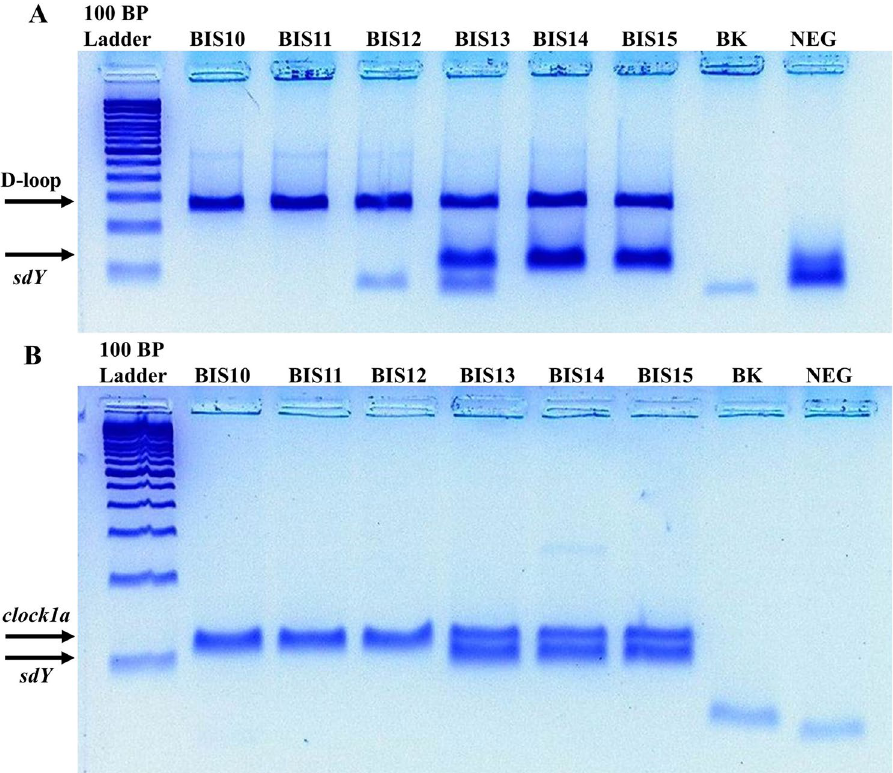
Figure 4. Negative images of electrophoresis gels showing the results of the ( A ) D-loop/ sdY and ( B ) clock1a / s dY PCR sex identification assays for six of the analyzed Pacific salmon ( Oncorhynchus spp.) samples (BIS#). The approximate positions of the internal positive control (D-loop and clock1a ) and sdY amplicons are indicated by the labelled arrows. BK denotes the blank extraction control processed alongside the samples. NEG denotes negative PCR controls. The 100 bp ladder is from Invitrogen (Vilnius, LT). PCR products were pre-stained with SYBR Green I (Invitrogen, Eugene, OR, USA). Unprocessed images of the electrophoresis gels are presented in Supplementary Fig. 1 and Supplementary Fig. 2.